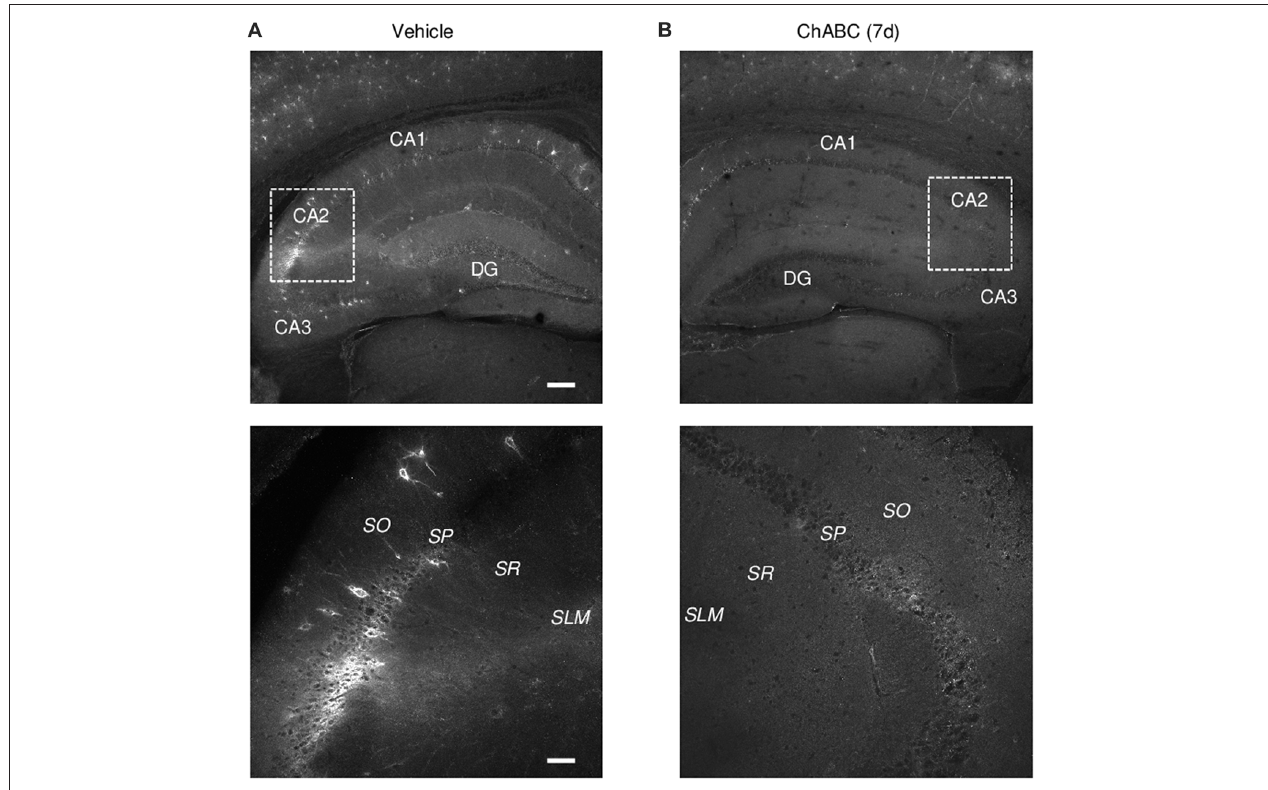
FIGURE 1 | Wisteria floribunda agglutinin (WFA) labeling of perineuronal nets (PNNs) 7 days (7 d) after intrahippocampal chondroitinase ABC (ChABC) injection. (A) WFA staining in a vehicle-injected hippocampus shows a strong labeling of PNNs with enrichment in the CA2 region. (B) WFA staining was abolished 7 days after ChABC injection in CA2. Scale bars, 200 and 50 µ m in the upper and lower rows,